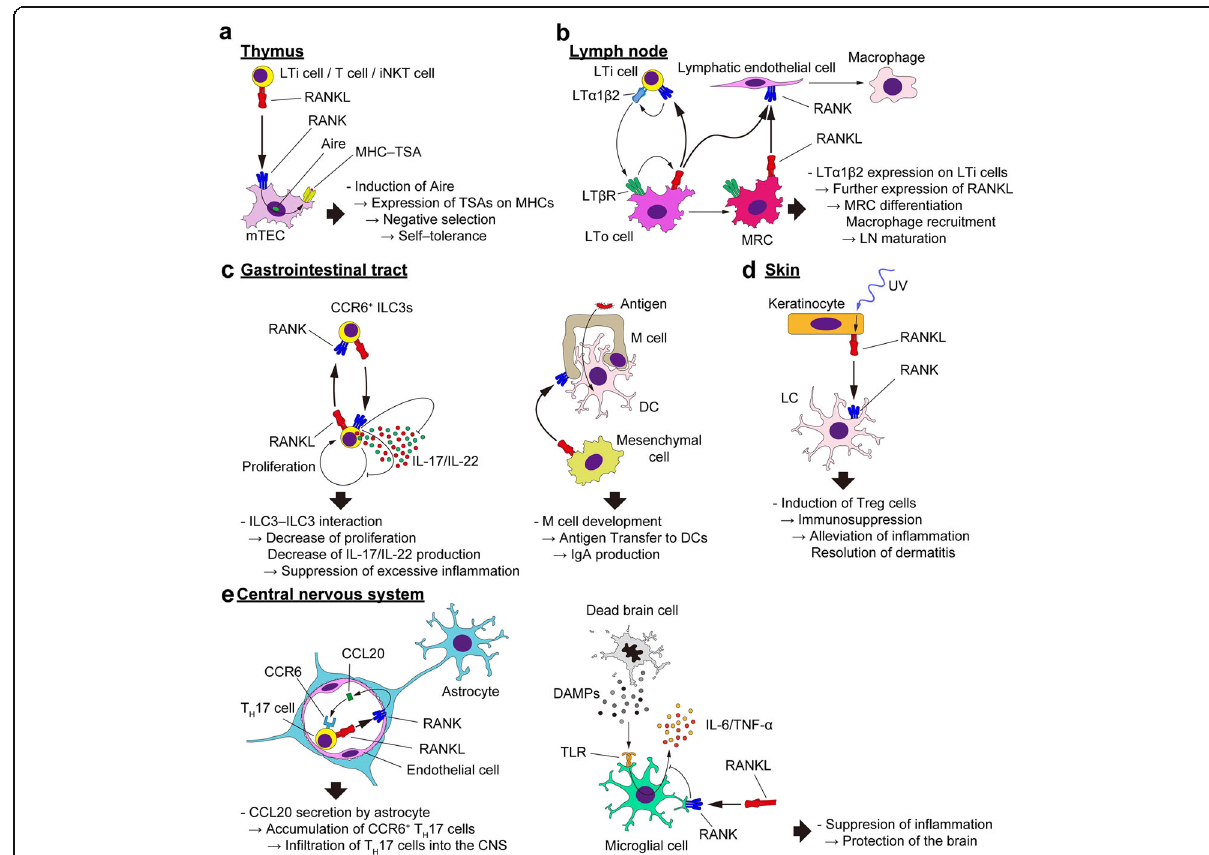
Fig. 2 RANKL in immunity. a RANKL – RANK interaction in the development of the thymus. RANKL is produced by LTi cells, T cells, and iNKT cells and interacts with the RANK expressed on mTECs. This interaction induces the expression of Aire, resulting in the expression of TSAs on MHC molecules. The TSA – MHC complex is necessary for negative selection, the key process for establishing self-tolerance. b RANKL – RANK interaction in the lymph node development. Lymph node development begins with the interaction between LTi cells and LTo cells. LT α 1 β 2 is expressed by LTi cells and interacts with LT β R on LTo cells, which in turn leads to the expression of RANKL on LTo cells. The expressed RANKL stimulates LTi cells to induce more LT α 1 β 2, forming a positive feedback loop. With the stimulation of LT α 1 β 2, some LTo cells mature into MRCs. The RANKL on LTo cells and MRCs binds to the RANK on lymphatic endothelial cells, resulting in the recruitment of macrophages. c RANKL – RANK interaction in the gastrointestinal tract. (Left) ILC3s interact with each other through RANKL and RANK. The interaction leads to the decrease of the proliferation and IL-17/IL-22 production of these cells, resulting in the suppression of excessive inflammation. (Right) RANKL – RANK interaction in M cell development. Mesenchymal cells beneath the epithelium of the gastrointestinal tract express RANKL and interact with RANK – expressing epithelial cells. These cells differentiate into morphologically and functionally unique cells called M cells. These cells enable the transfer of antigens from the lumen of gastrointestinal tract to DCs, leading to IgA production. d RANKL – RANK interaction in the skin. Keratinocytes express RANKL upon UV – irradiation. The RANKL binds to LCs in the skin. These LCs contribute to the generation of Treg cells, which decrease the skin inflammation and resolution of dermatitis in psoriasis and atopic dermatitis. e RANKL – RANK interaction in the CNS inflammation. (Left) T H 17 cell cells induce the CCL20 expression of astrocytes at the blood – brain barrier via RANKL – RANK signaling. CCL20 recruits CCR6-expressing cells, including T H 17 cell cells. These accumulated cells penetrate the barrier and infiltrate into the CNS to elicit inflammation. (Right) In the context of ischemic stroke, dead cells in the brain release DAMPs, which are recognized by TLRs. TLR stimulation of microglial cells leads to the production of pro- inflammatory cytokines including IL-6 and TNF- α , leading to inflammation and further cell death. RANKL – RANK signal in the microglial cells inhibits the production of these cytokines, resulting in the protection of the brain. RANKL receptor activator of NF- κ B ligand, RANK receptor activator of NF- κ B, LTi cell lymphoid tissue inducer cell, iNKT cell invariant natural killer T cell, mTEC medullary thymic epithelial cell, Aire autoimmune regulator, TSA tissue-specific antigen, MHC major histocompatibility complex, LTo cell lymphoid tissue organizer cell, LT lymphotoxin, LT β R lymphotoxin β receptor, MRC marginal reticular cell, ILC3 group 3 innate lymphoid cell, IL interleukin, DC dendritic cell, UV ultra violet,